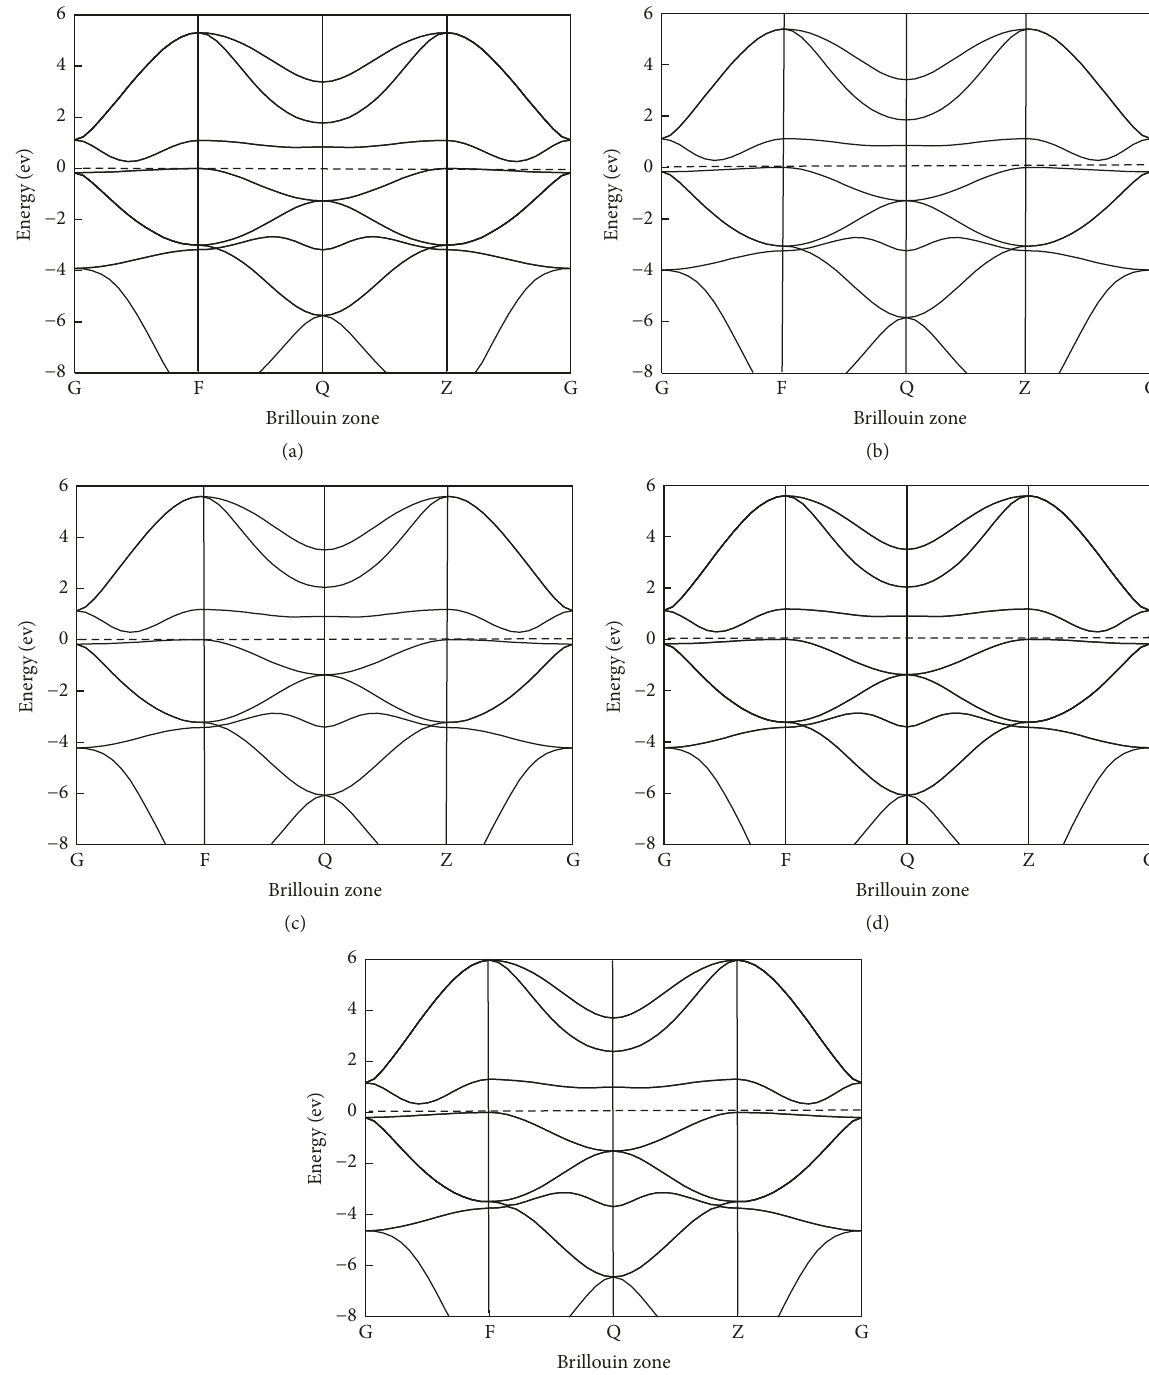
Figure 3: Electron band structure: (a) under 0MPa stress; (b) under 5 MPa stress; (c) under 10MPa stress; (d) under 15 MPa stress; (e) under 20 MPa